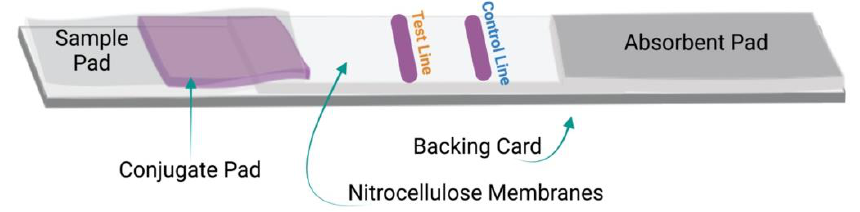
Figure 1. Components of LFIA devices: Schematic of the general components and design of the LFIA LFIA strips.